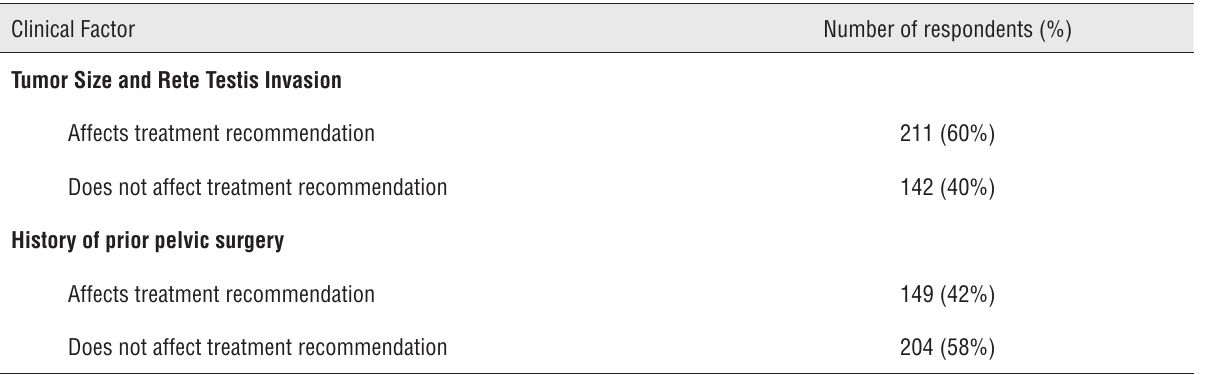
Table 3 - Influence of clinical factors on treatment